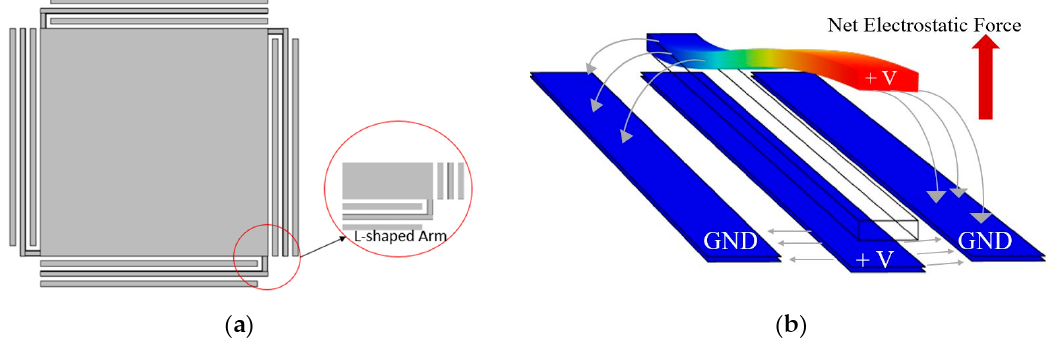
Figure 2. ( a ) Top view of the micromirror showing the L-shaped arm and three fixed bottom electrodes generated using COMSOL simulation software and ( b ) schematic view of the arm and the three bottom electrodes. COMSOL simulation results shows the distribution of generated electrostatic force and the upward movement of the. The device physical properties are provided in Table 1.